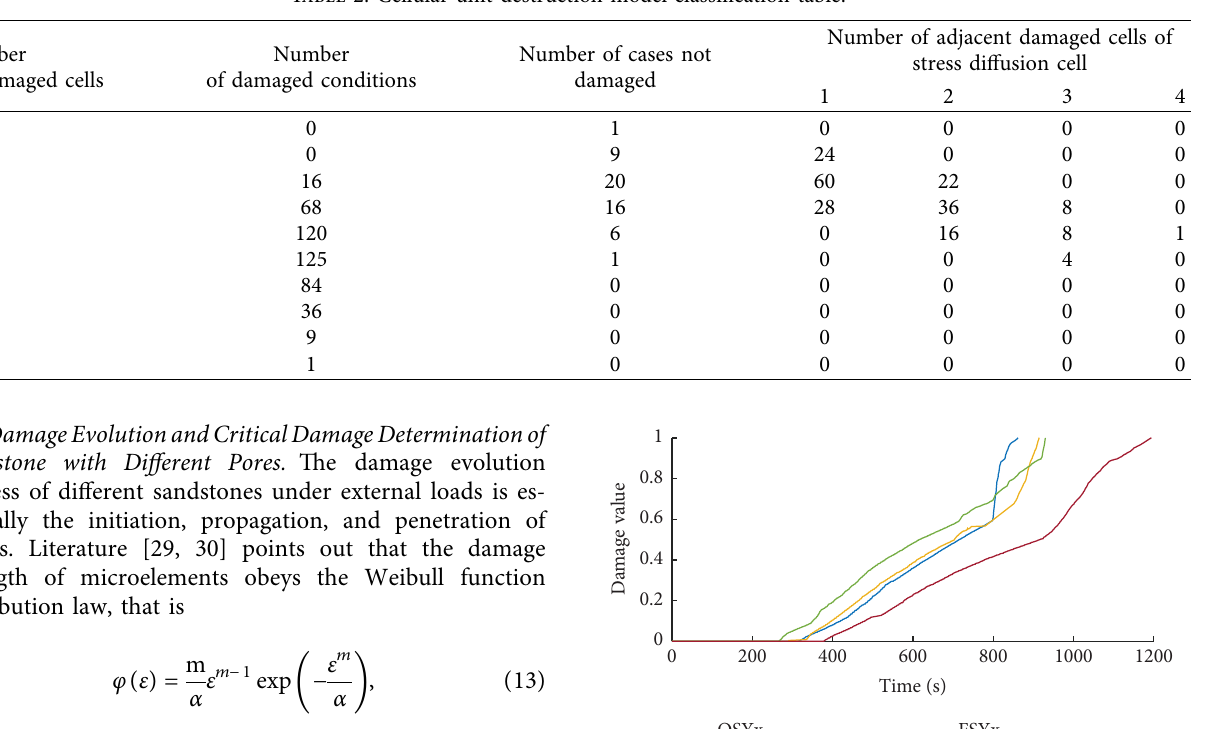
Table 2: Cellular unit destruction model classification table.